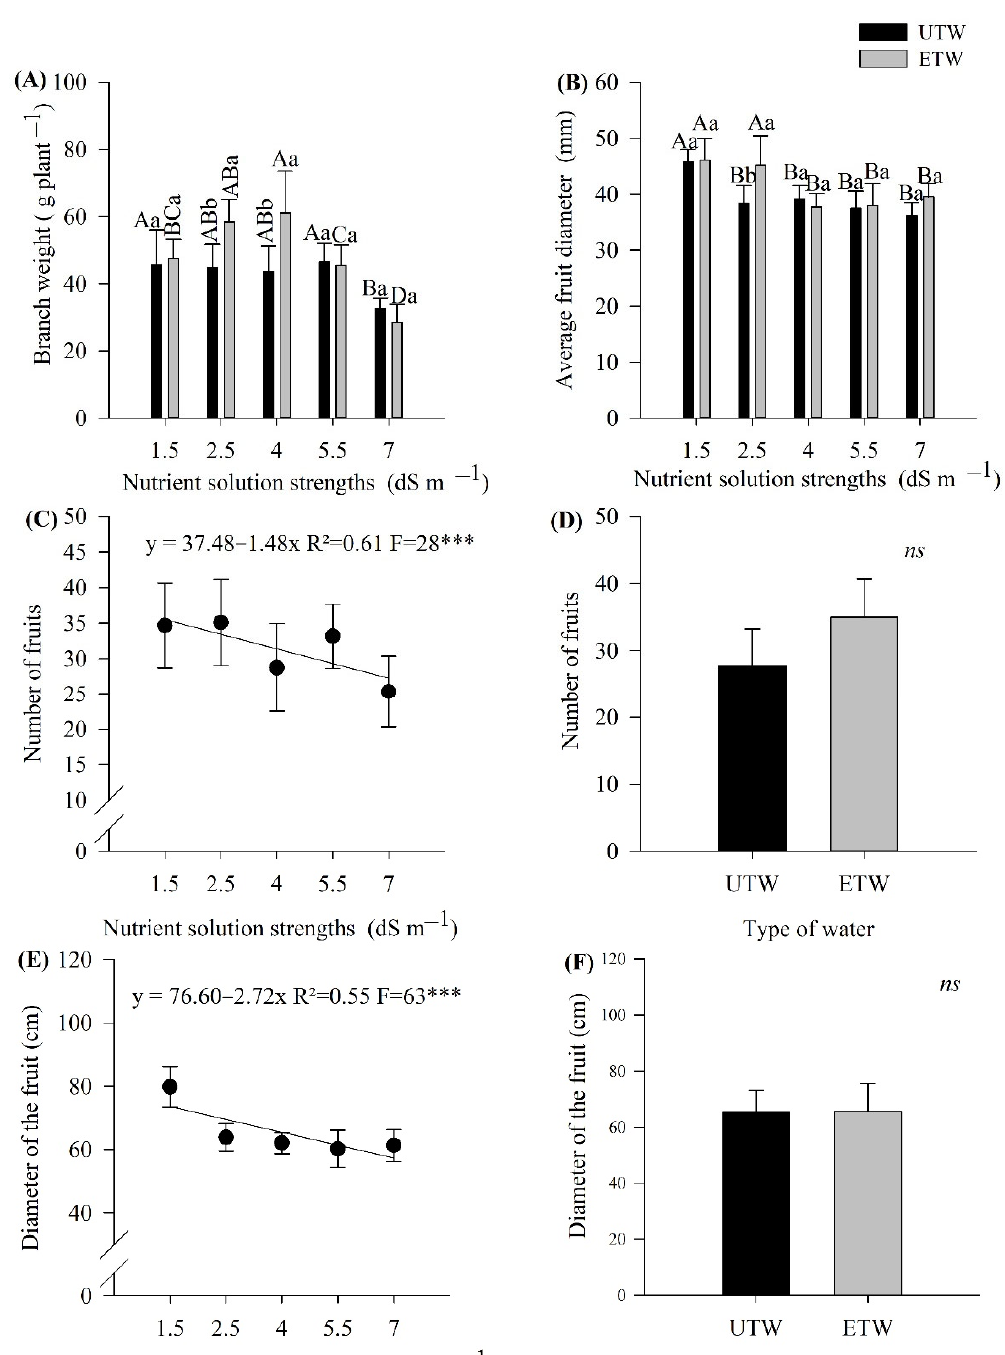
Figure 2. Biometric parameters of the tomato crop fruits were subjected to different strength nutrient solution with electromagnetically treated water (ETW) and untreated water (UTW) ( A ) Branch Weigth, ( B ) Average fruits diameter, ( C , D ) Number of fruits, ( E , F ) Diameter of fruits. According to the Tukey test, the means followed by the same letter, lower case comparing the type of water and upper case comparing nutrient solution strength do not differ statistically ( p < 0.05). The error bars indicate the standard deviation of the average of four repetitions ( n = 4). ns: not significant, *** significant at